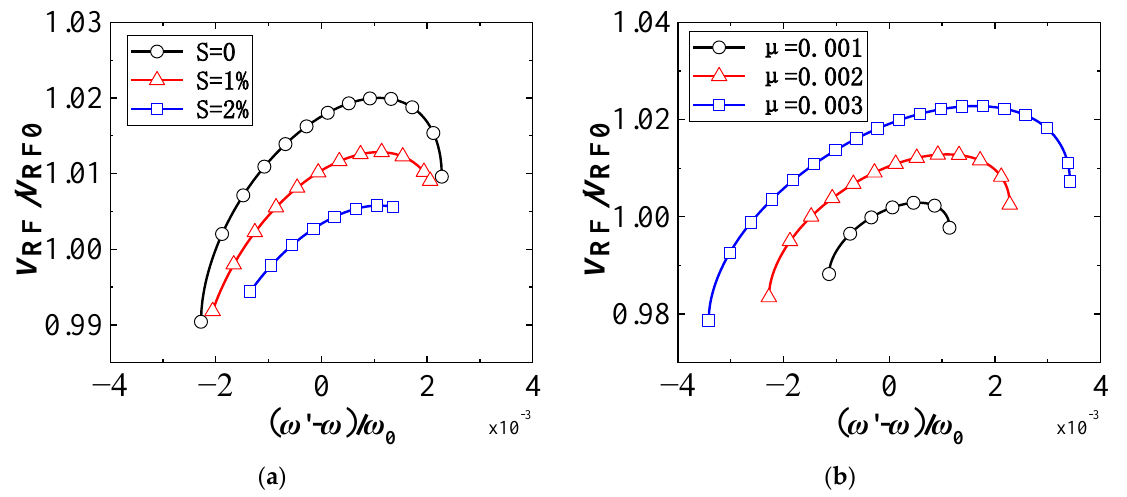
Figure 3. The injection locking performance with respect to the ( a ) power supply ripple S and ( b ) injection amplitude µ , with the frequency pushing effect α . Table 3. Comparison of injection locking in different ripples.